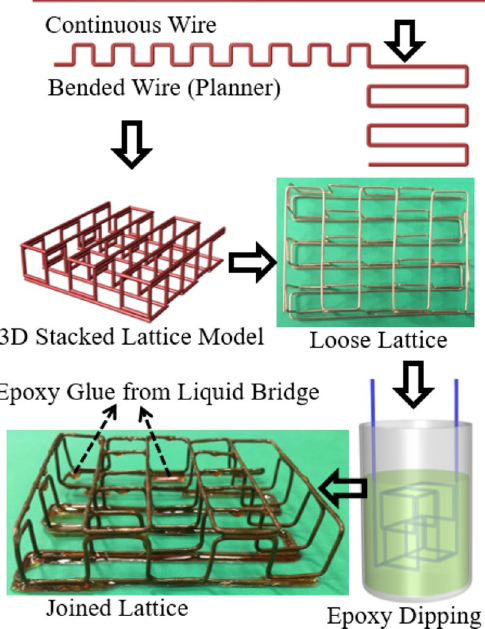
Figure 3. Sample lattice structure fabrication by joining the node with the epoxy polymer.